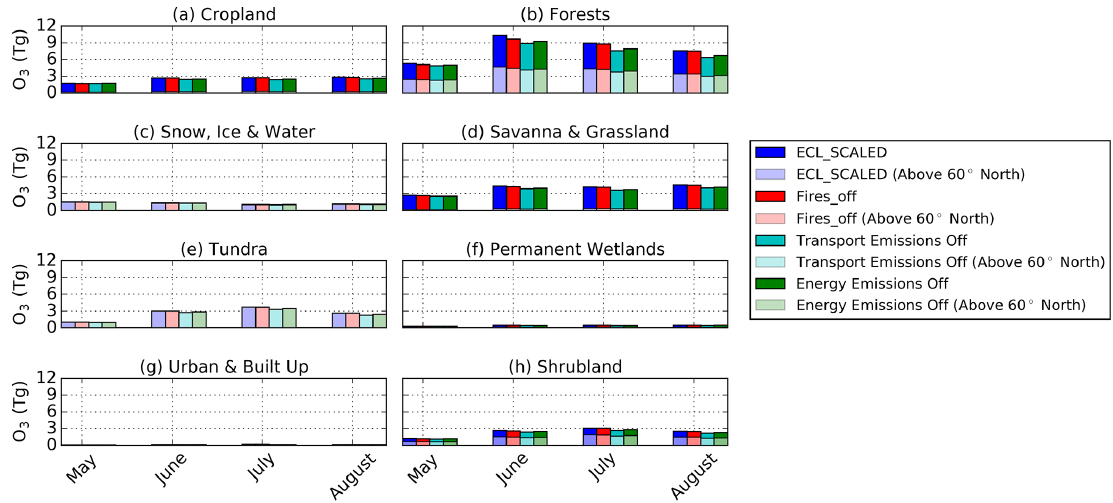
Figure 11. Quantity of ozone deposited to modified IGBP MODIS Noah land surface cover categories per month for total domain (solid bars) and for the section of the domain north of 60 ◦ N (pale